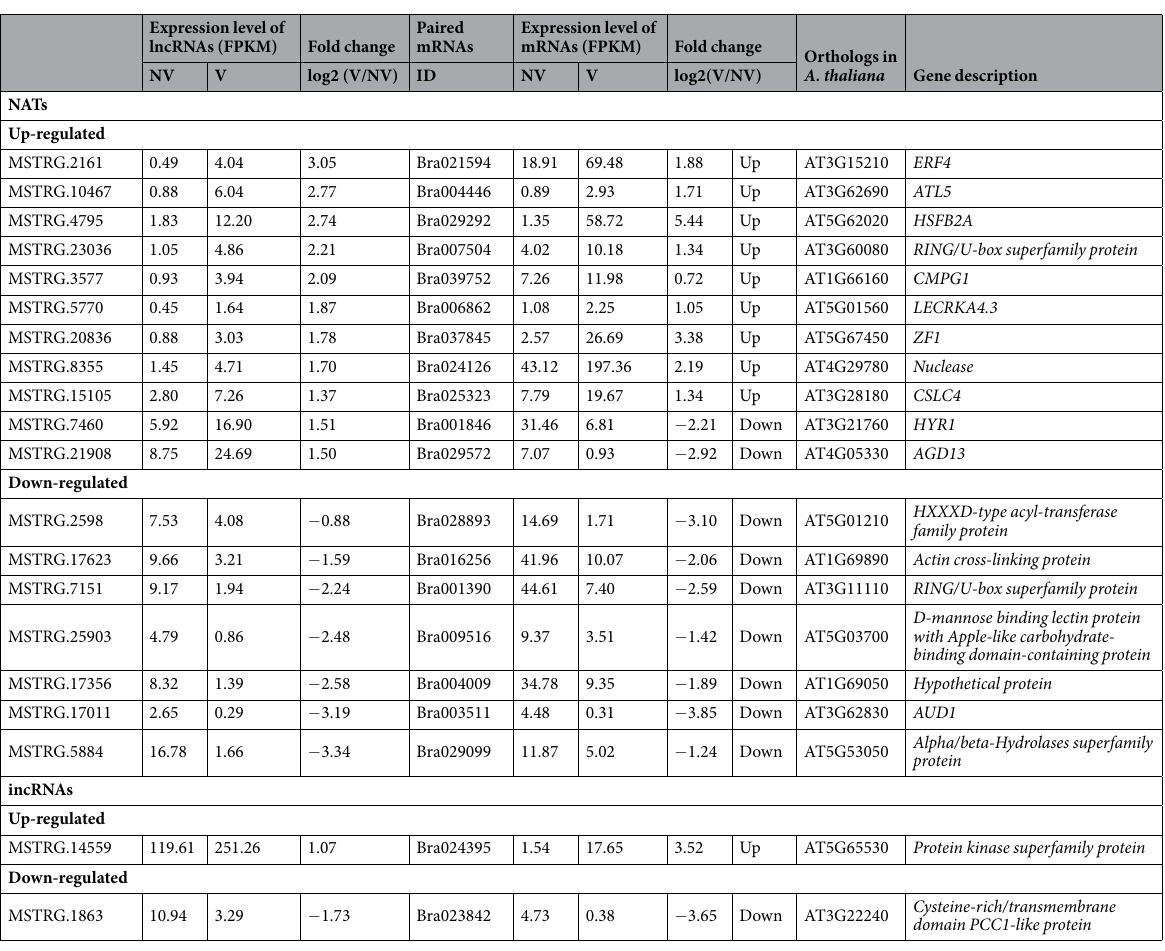
Table 1. Differentially expressed NATs or incRNAs by four weeks of cold